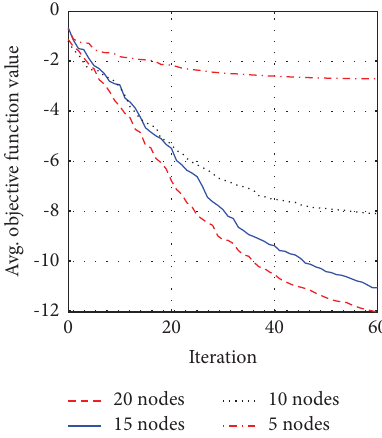
Figure 10: Average objective function value against algorithm iterations.